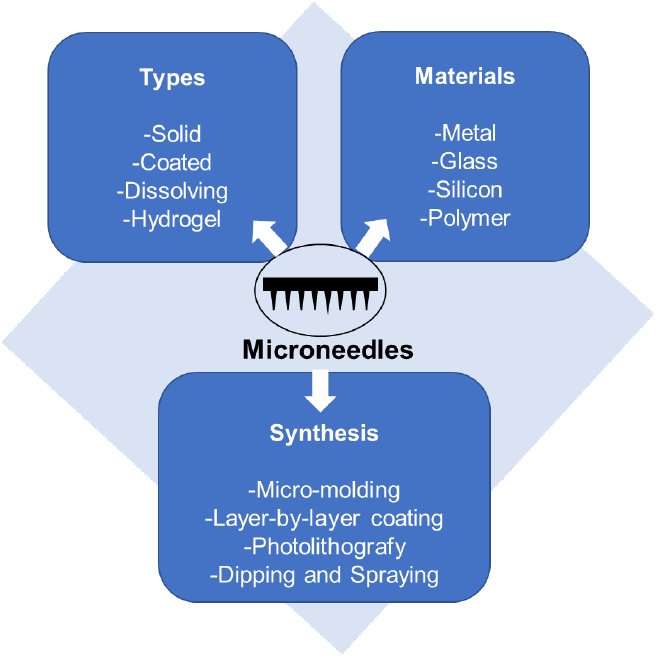
Figure 4. Diagram summarizing microneedle types, materials and production methods.